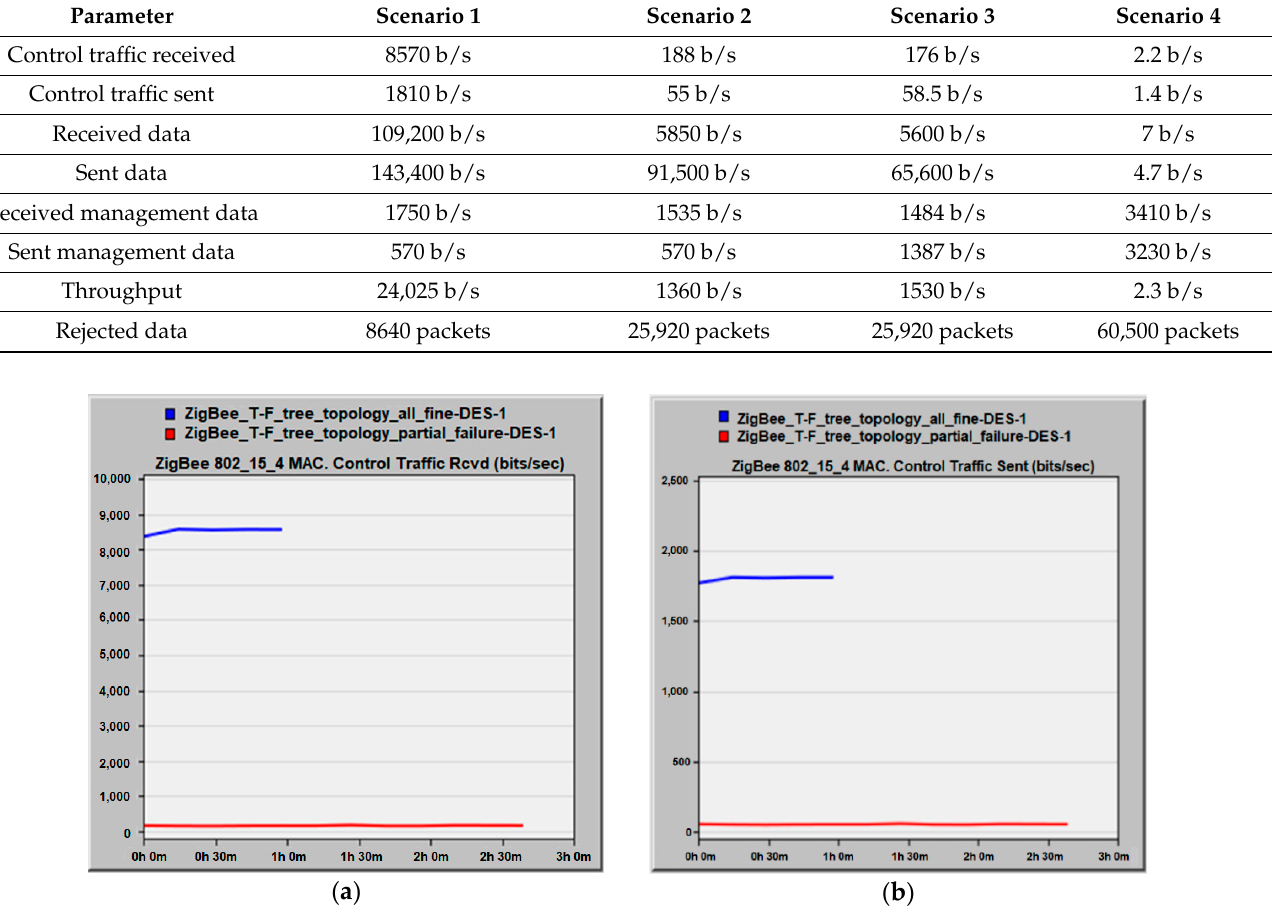
( b ) Figure 7. ( a ) Received management data in bits per second ; ( b ) Sent management data in bits per second .